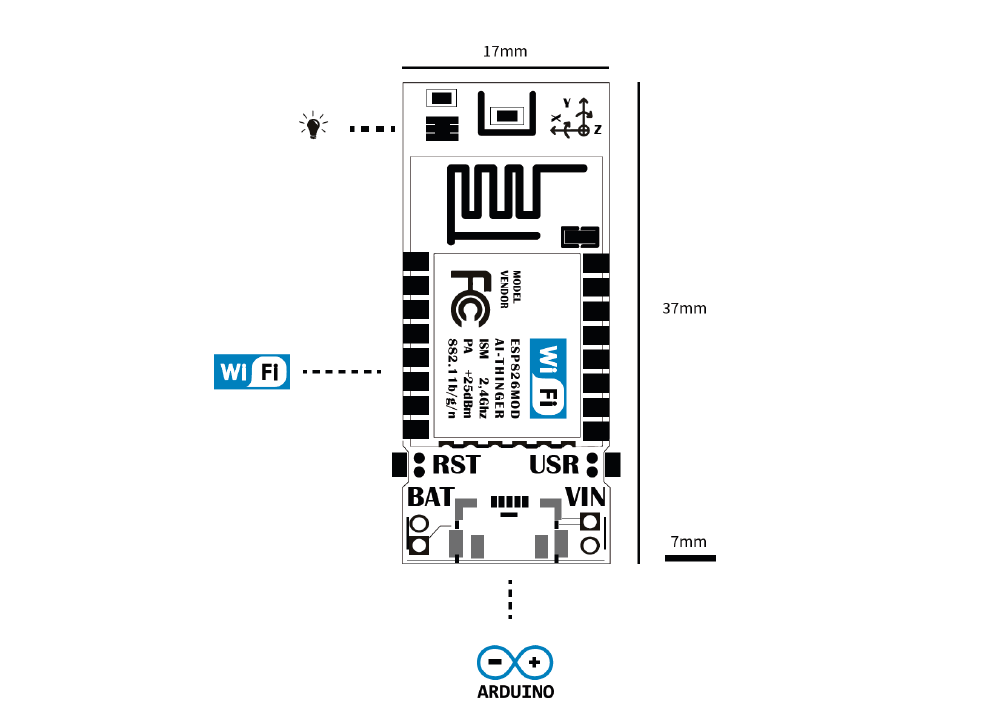
Figure 16. Thinger.io logical